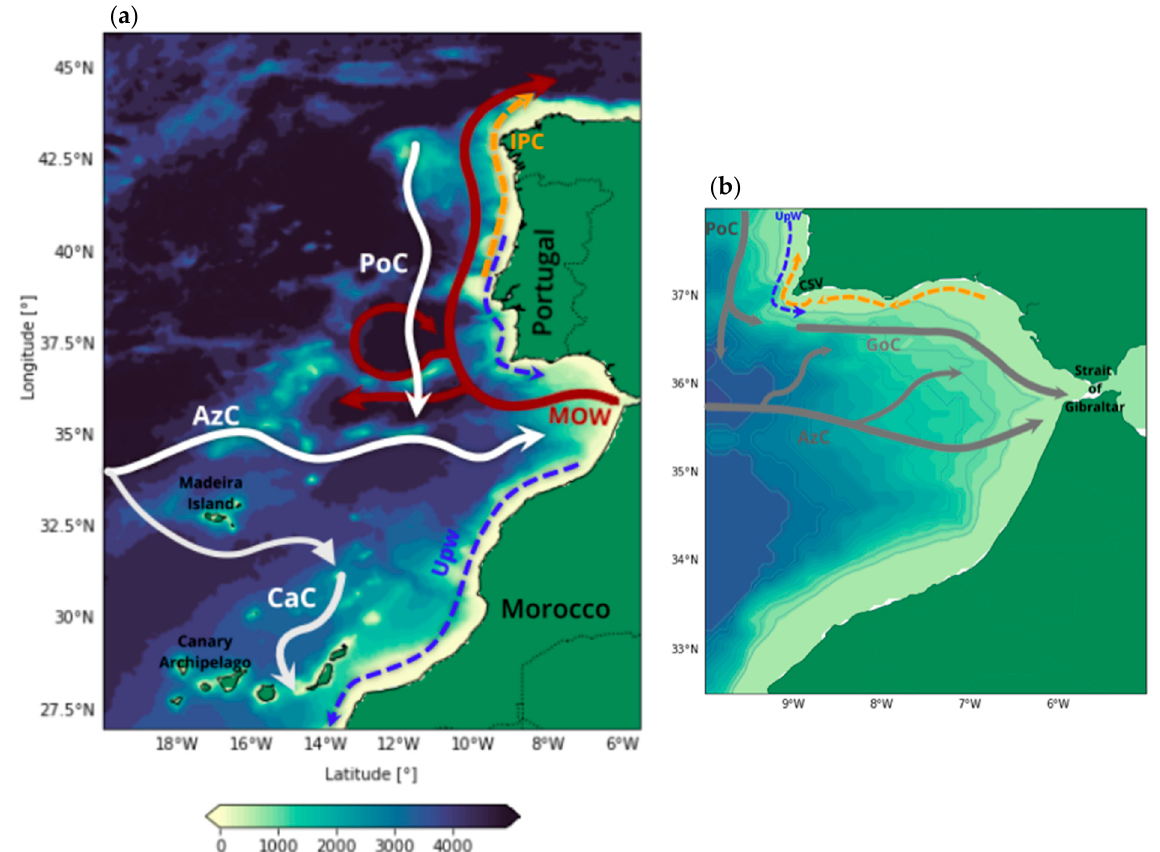
Figure 1. Schematic representation of the general circulation in the Iberian and Canary Current system ( a ) and upper general circulation of the southwest Iberian region ( b ). AzC—Azores Current; CaC—Canary Current; GoC—Gulf of Cadiz Current; IPC—Iberian Poleward Current; MOW—Mediterranean outflow water; PoC—Portuguese Current; UpW—upwelling coastal circulation; CSV—Cape St Vincent.